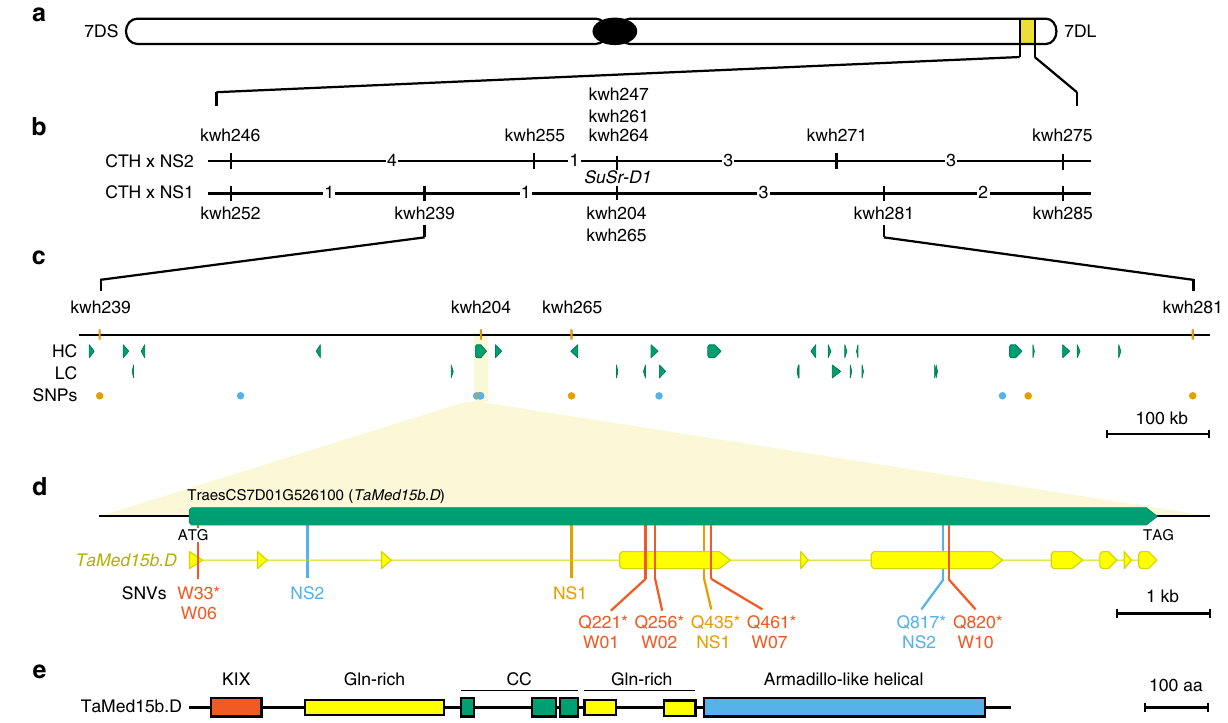
Fig. 2 SuSr-D1 encodes Med15b.D, a subunit of the mediator complex. a SuSr-D1 is located in the distal region of the long arm on chromosome 7D. b Genetic maps of SuSr-D1 in the NS1 and NS2 DH populations. The values between loci represent the number of recombinants observed in that interval on which the genetic maps in Supplementary Fig. 5 were based. c Physical interval encompassing SuSr-D1 with annotated high (HC) and low (LC) con fi dence genes (green). d Structure of the Med15b.D gene encoded by SuSr-D1 . Exons are represented by thicker segments and introns are represented by thin lines (yellow). NS1 (orange) and NS2 (sky blue) each carry a mutation within an intron as well as the loss-of-function mutations labeled as Q435* NS1 and Q817* NS2. Additional CTH mutations (vermillion) shown are: Q221* W01, Q256* W02, W33* W06, Q461* W07, Q820* W10, and Q820* W11. e Med15b.D encodes a 1301 aa protein with KIX (CREB-binding domain 93 ; vermillion), Gln-rich (yellow), coiled coil (green), and Armadillo-like helical (blue)